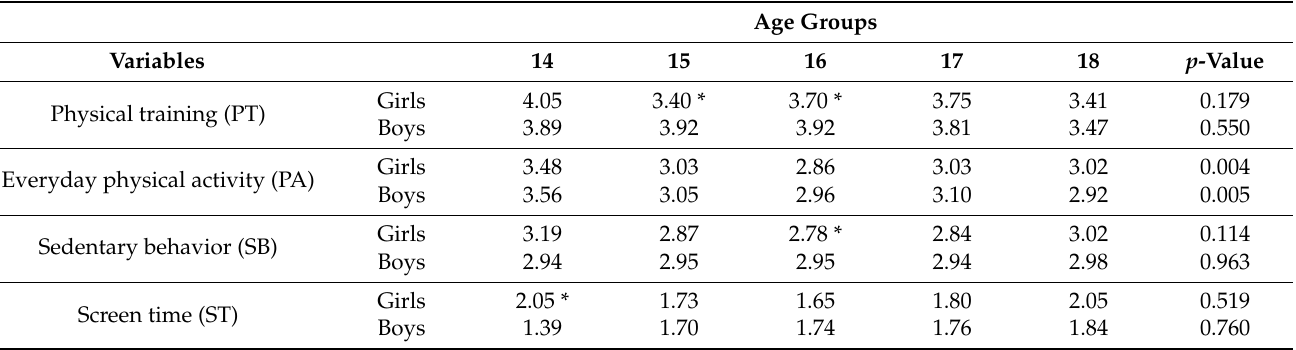
Table 2. Kruskal–Wallis and Mann–Whitney Tests comparing differences in PA between sexes and age groups. Mean value is presented for age and